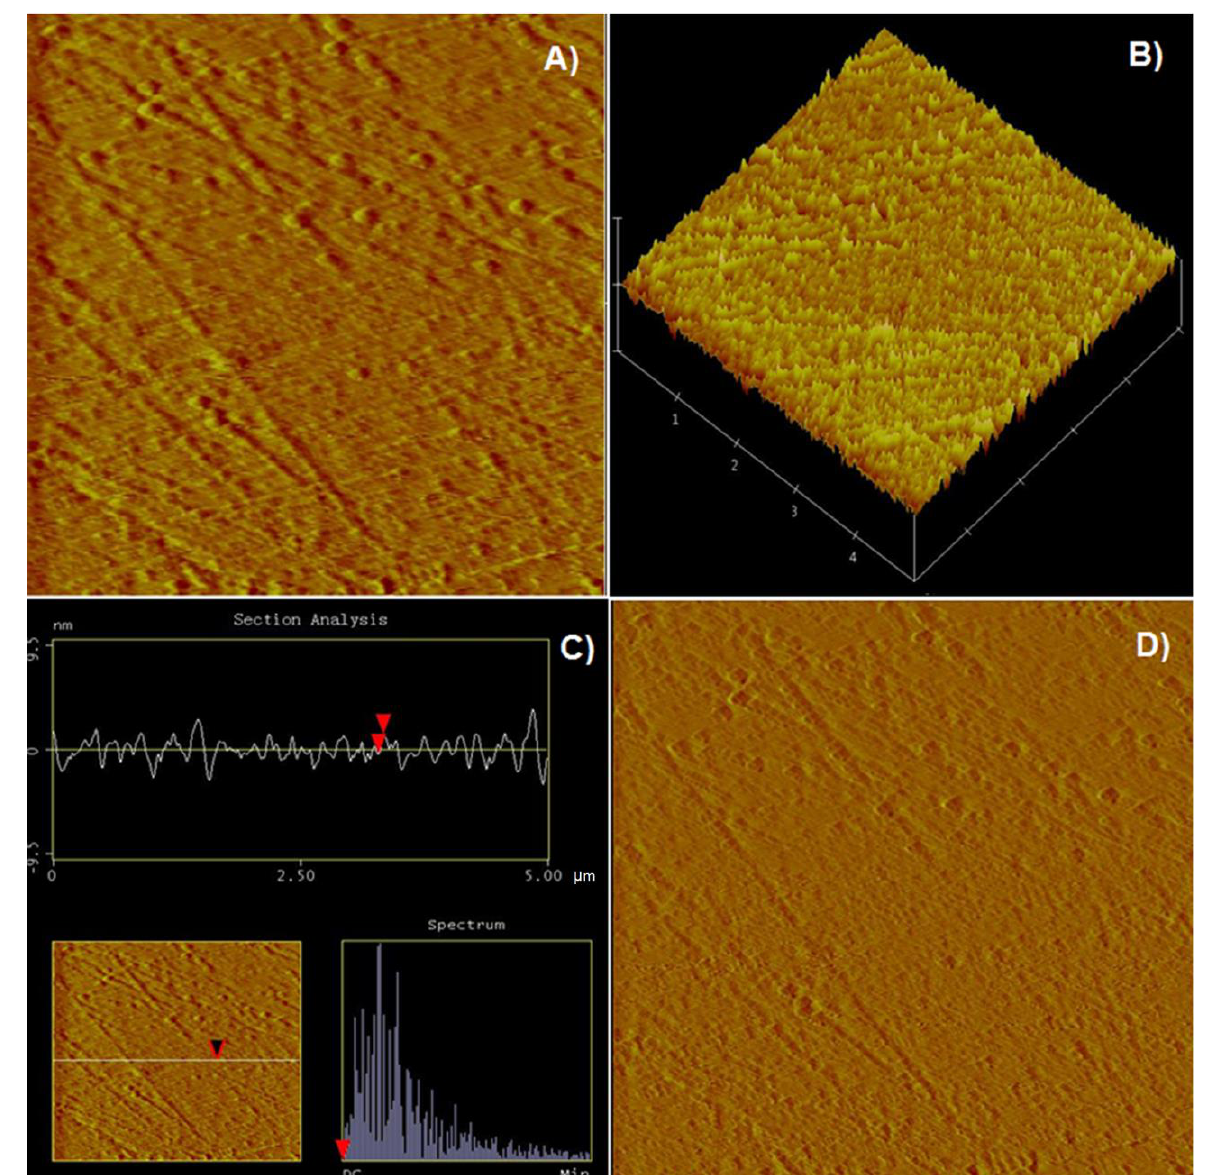
Figure 8. AFM images of a bornite surface soaked in the 1 × 10 − 5 M PAX solution at pH 6 for 10 min. ( A ) The 5 µm × 5 µm height image with a data scale of 20 nm, ( B ) the 3D image, ( C ) the section analysis (the red arrows indicate the top and the bottom of an average asperity) and ( D ) the deflection image with a data scale of 10 nm.